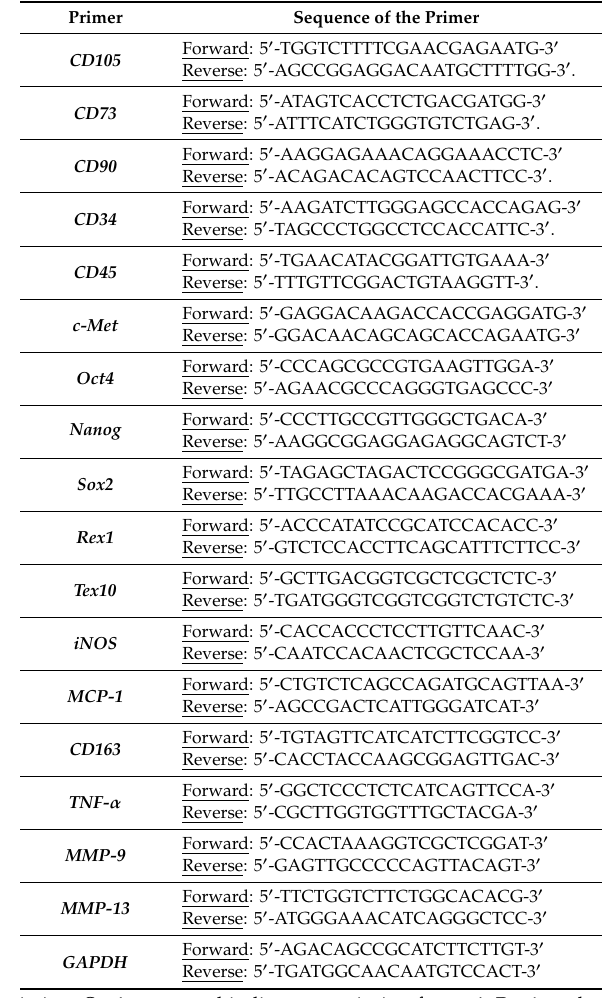
Table 2. Primers used in